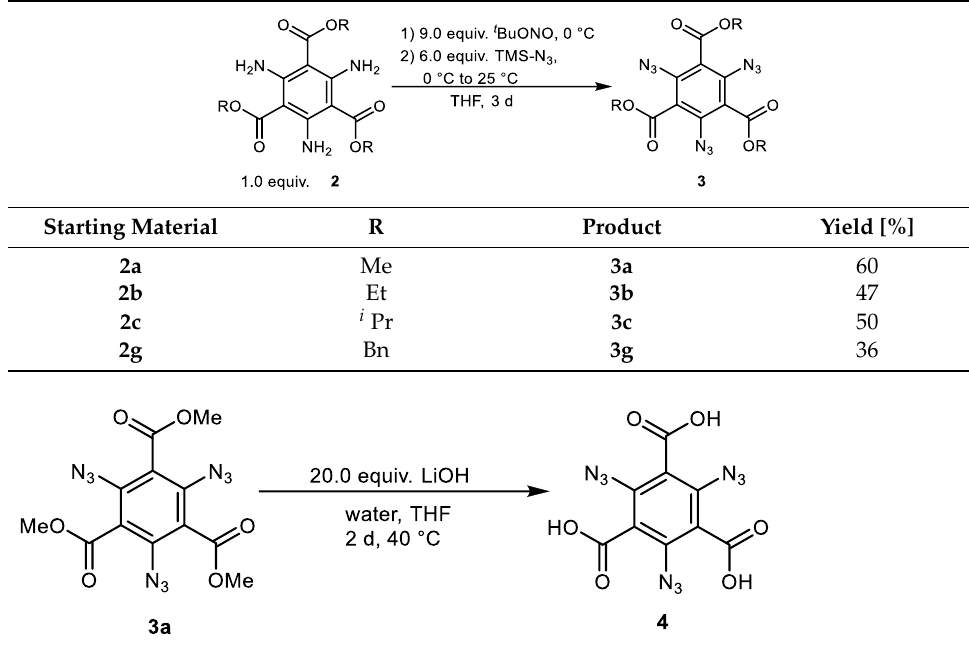
Table 2. Syntheses of triazides 3a – c , g .